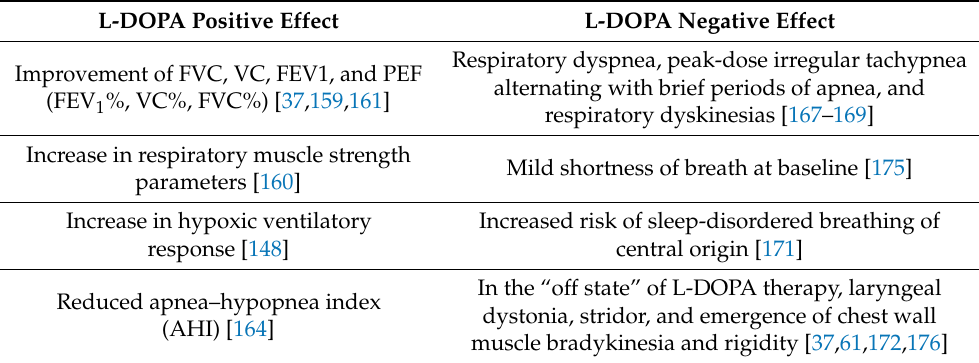
Table 3. Effects of L-dopa treatment on breathing. L-DOPA Positive Effect L-DOPA Negative